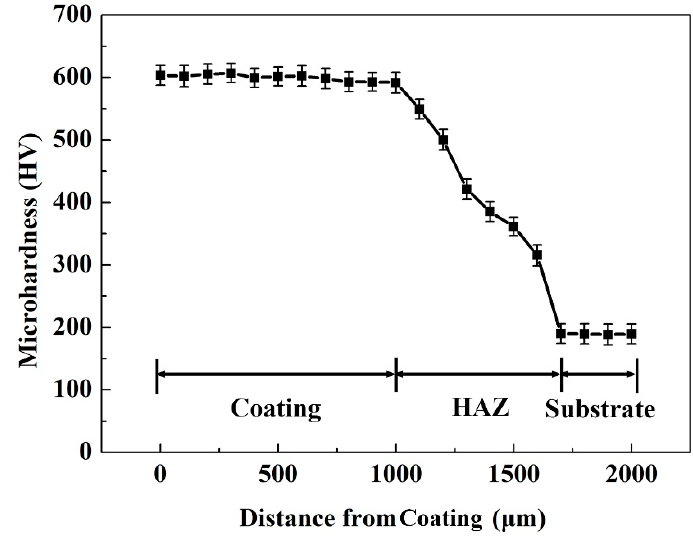
Figure 6. The microhardness profile along the cross-section of the coating.